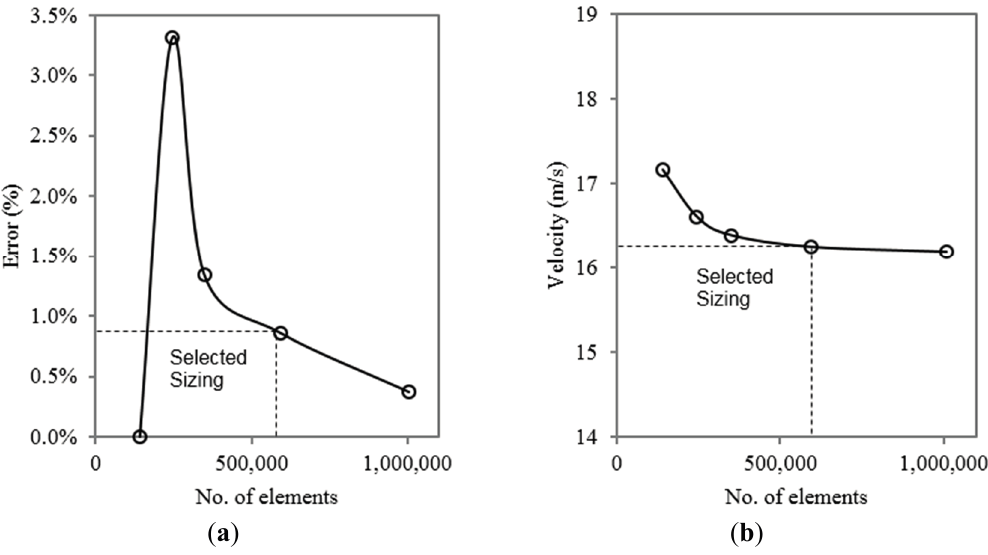
Figure 5. ( a ) Posterior error on the average velocity in the test-section using h-method. ( b ) Variation in test section velocity at increasing number of